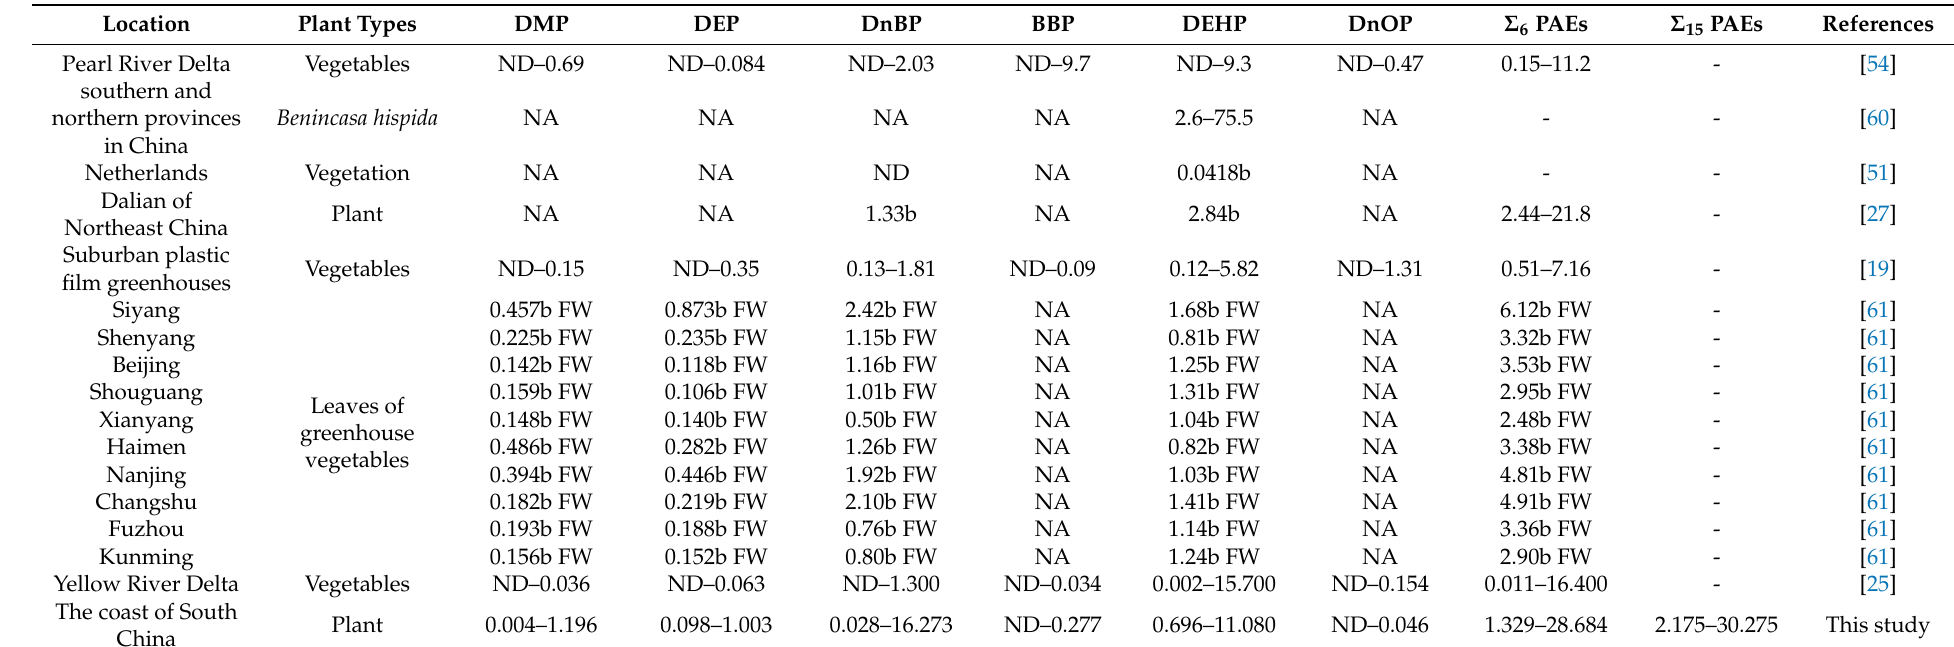
Table 4. Comparison of concentration of PAEs in plants of different regions (mg/kg, dry